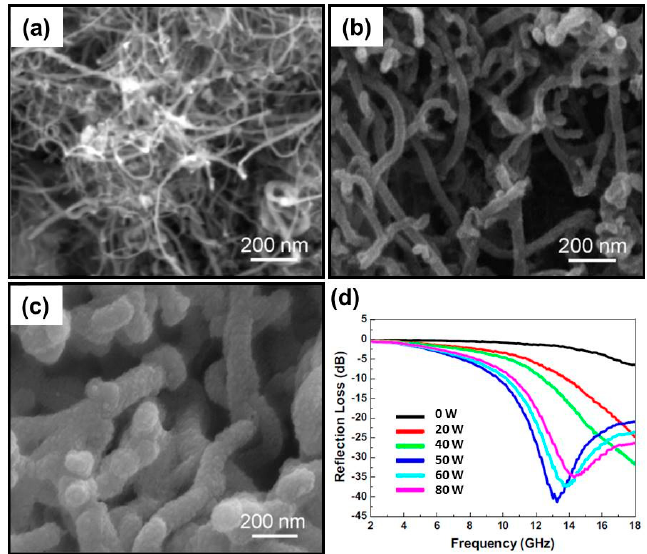
Figure 11. ( a ) SEM image of CNTs; ( b ) SEM image of CNT/PANI hybrids without plasma ( c ) SEM image of CNT/PANI hybrids with plasma pretreatment; ( d ) Frequency dependence of the pretreatment; ( c ) SEM image of CNT/PANI hybrids with plasma pretreatment; ( d ) Frequency reflection loss of CNT/PANI hybrids with different plasma pretreatment power (W) in 2–18 GHz. dependence of the reflection loss of CNT/PANI hybrids with different plasma pretreatment power Reprinted with permission from Reference (W) in 2–18 GHz. Reprinted with permission from Reference [139].